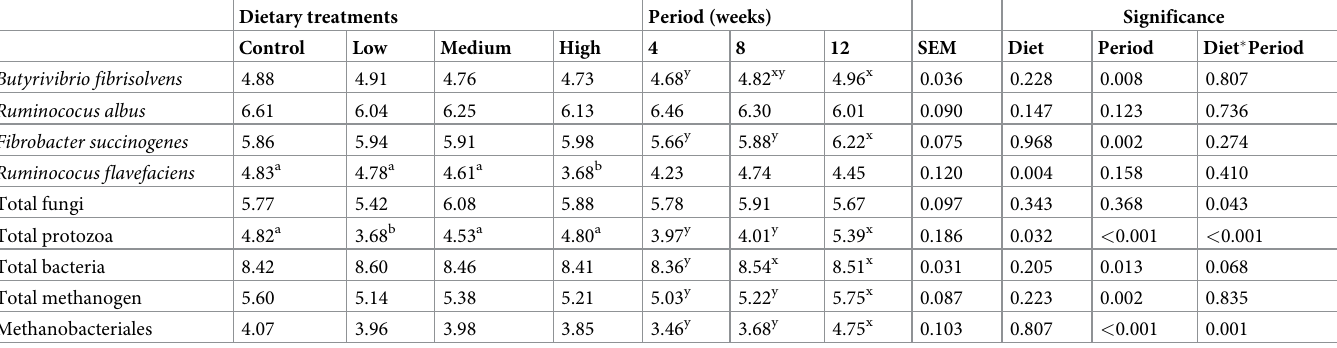
Table 7. Effects of increasing levels of lovastatin on microbial population log10 copy number/ml rumen fluid. Dietary treatments